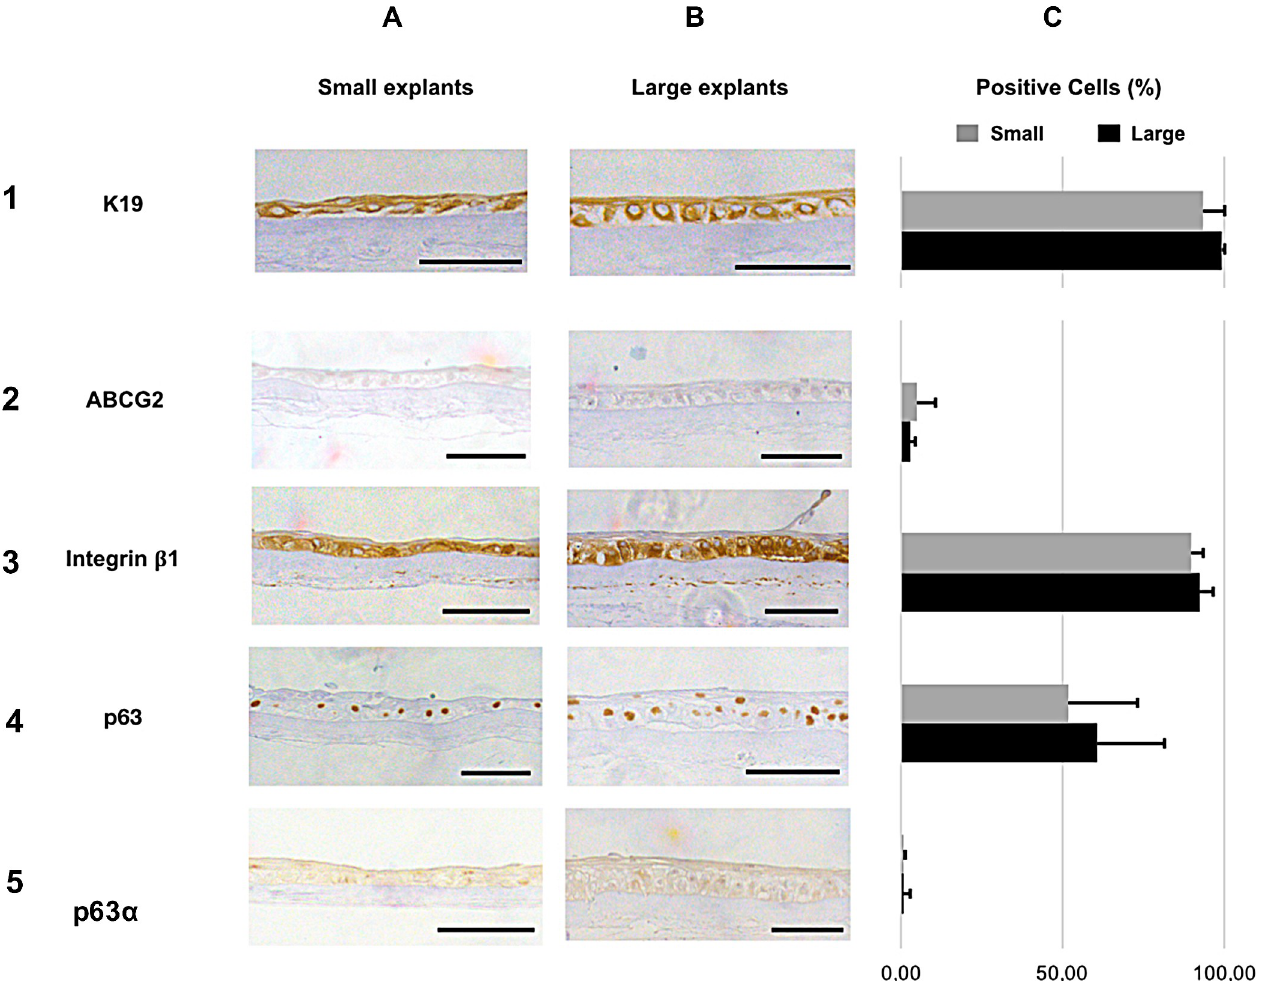
Fig 7. Immunostaining (A and B) and Quantification (C) of immature phenotype markers. A and B. Immunostaining of 1) K19, 2) ABCG2, 3) integrin β 1, 4) p63, and 5) p63 α of cultured human LEC derived from small (A) and large (B) limbal explants. The selected areas in the micrographs are representative for the staining and not for the epithelial thickness in the study groups. Scale bar = 100 μ m. C : Bar charts showing the percentage of positive cells for the immature phenotype markers in cultured LEC sheets cells derived from small (grey) and large (black) explants. � P < 0.05. �� P < 0.01. Error bars represent the standard deviation of mean